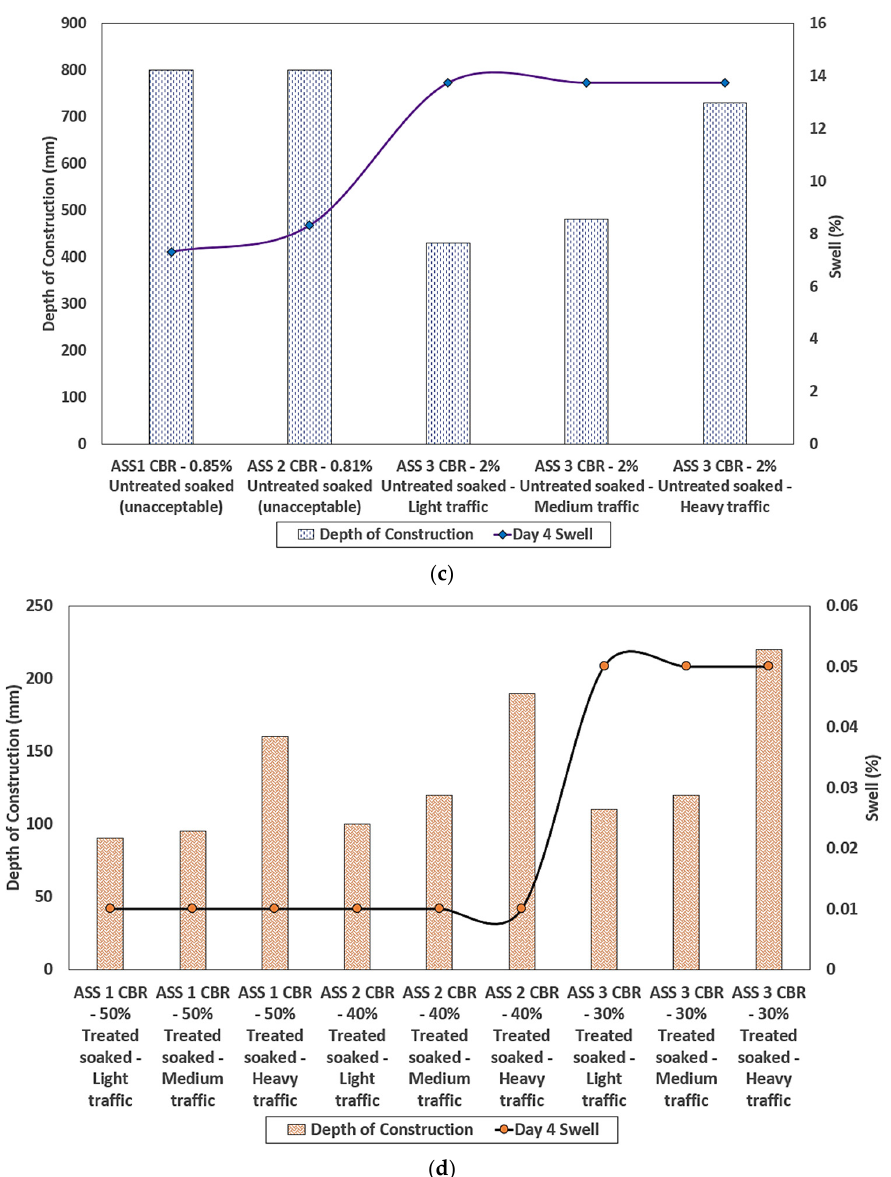
Figure 16. ( a ) Day 4 soaked pavement thickness against day 4 swell values for untreated ASS sam- ples; ( b ) day 4 soaked pavement thickness against day 4 swell values for treated ASS samples; ( c ) day 4 soaked depth of construction against day 4 swell values for untreated ASS samples; ( d ) day 4 soaked depth of construction against day 4 swell values for treated ASS